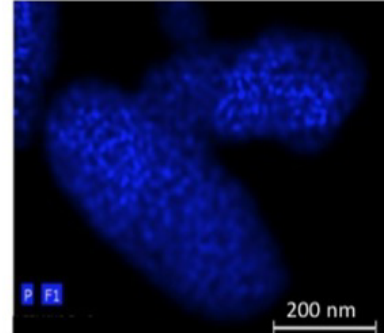
coated LiMn Ni O 4 1.5 0.5 4